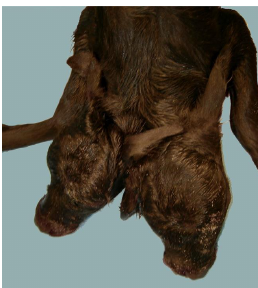
Figure 1. Dicephalic derodymus newborn MIRB calf with complete duplication of cranial structures up to the neck.